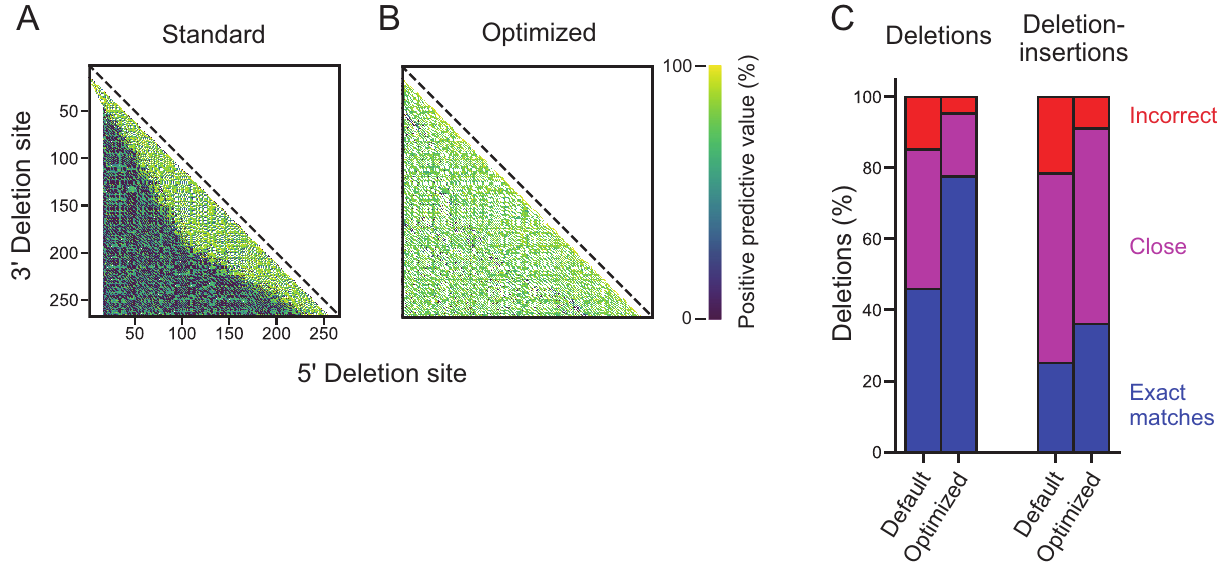
Fig 4. Alignment optimization. Interaction maps for deletion sites identified from the deletion dataset of synthetic reads for BWA-MEM alignment with ( A ) default parameters and ( B ) optimized algorithm. The optimized analysis incorporates custom BWA-MEM parameters, ambiguous site removal, and exact edge matching. Points correspond to specific 5’ and 3’ deletion sites and are colored by the percent of total deletion sites correctly mapped to a specific nucleotide pair (see scale). ( C ) Summary of accuracies pre- and post-optimization for synthetic deletion ( left ) and deletion-insertion ( right ) datasets. See Methods for full summary of